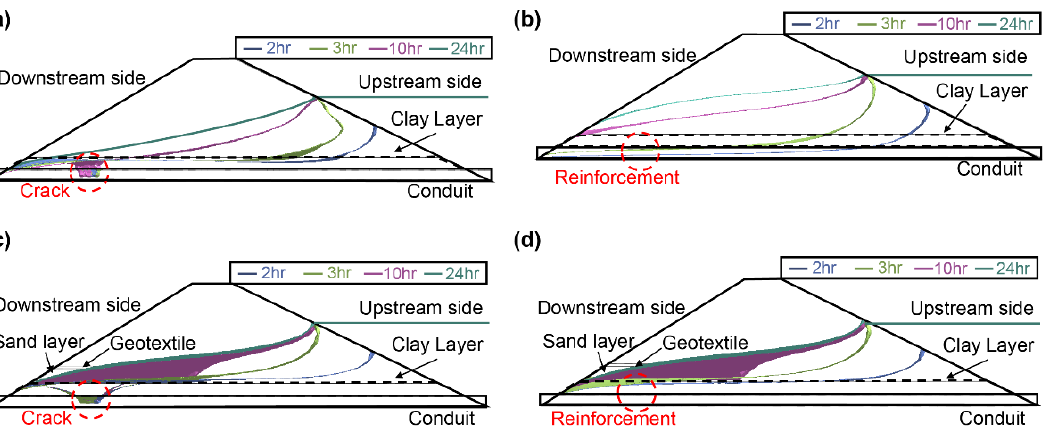
Figure 8. Changes in seepage line in current and improvement models: ( a ) Case 1—Crack, ( b ) Case 1—Reinforcement, ( c ) Case 2—Crack, ( d ) Case 2—Reinforcement. 1—Reinforcement, ( c ) Case 2—Crack, ( d ) Case